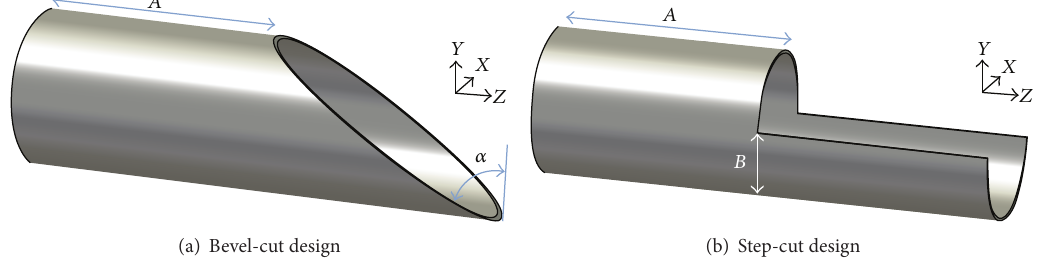
Figure 1: Configurations and parameters of bevel- and step-cut Vlasov